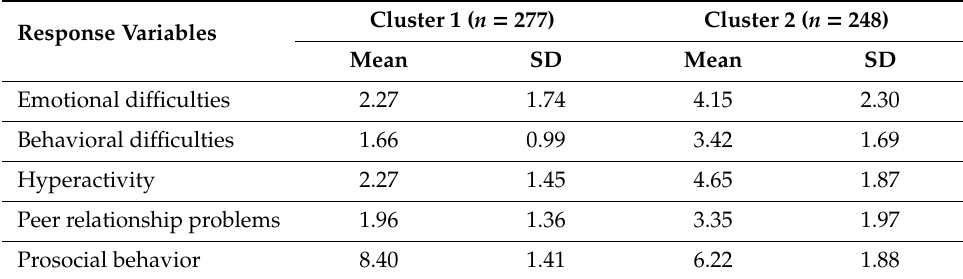
Table 6. Descriptions of response variables by